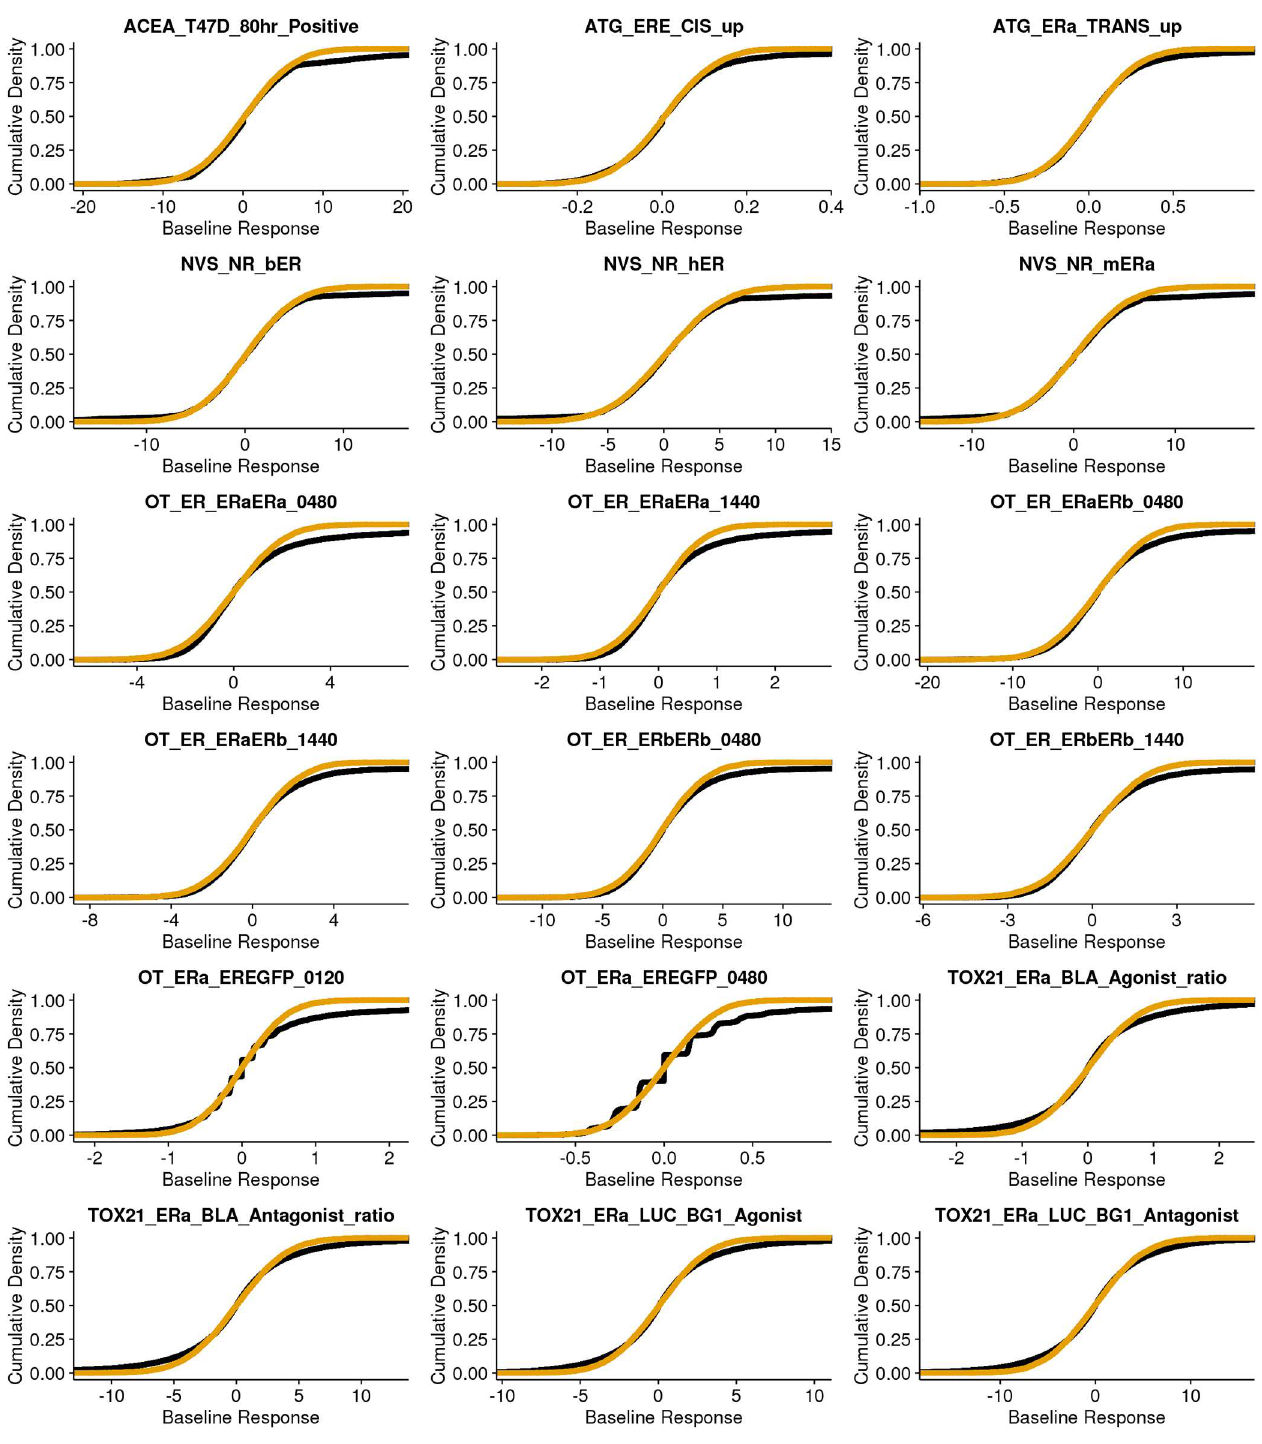
Fig 1. Comparison of normal distribution with standard deviation equal to bmad (orange line) and the empirical cumulative distribution function (ecdf) for points used to calculated bmad (black line). For each assay, the bmad is calculated as the scaled mad of the response values for the lowest two concentrations per chemical. Deviations between the ecdf and the normal distribution at higher response values can be attributed to highly potent chemicals with a biological response at the lowest two concentrations as well as sources of noise that are from a non-normally distributed process.